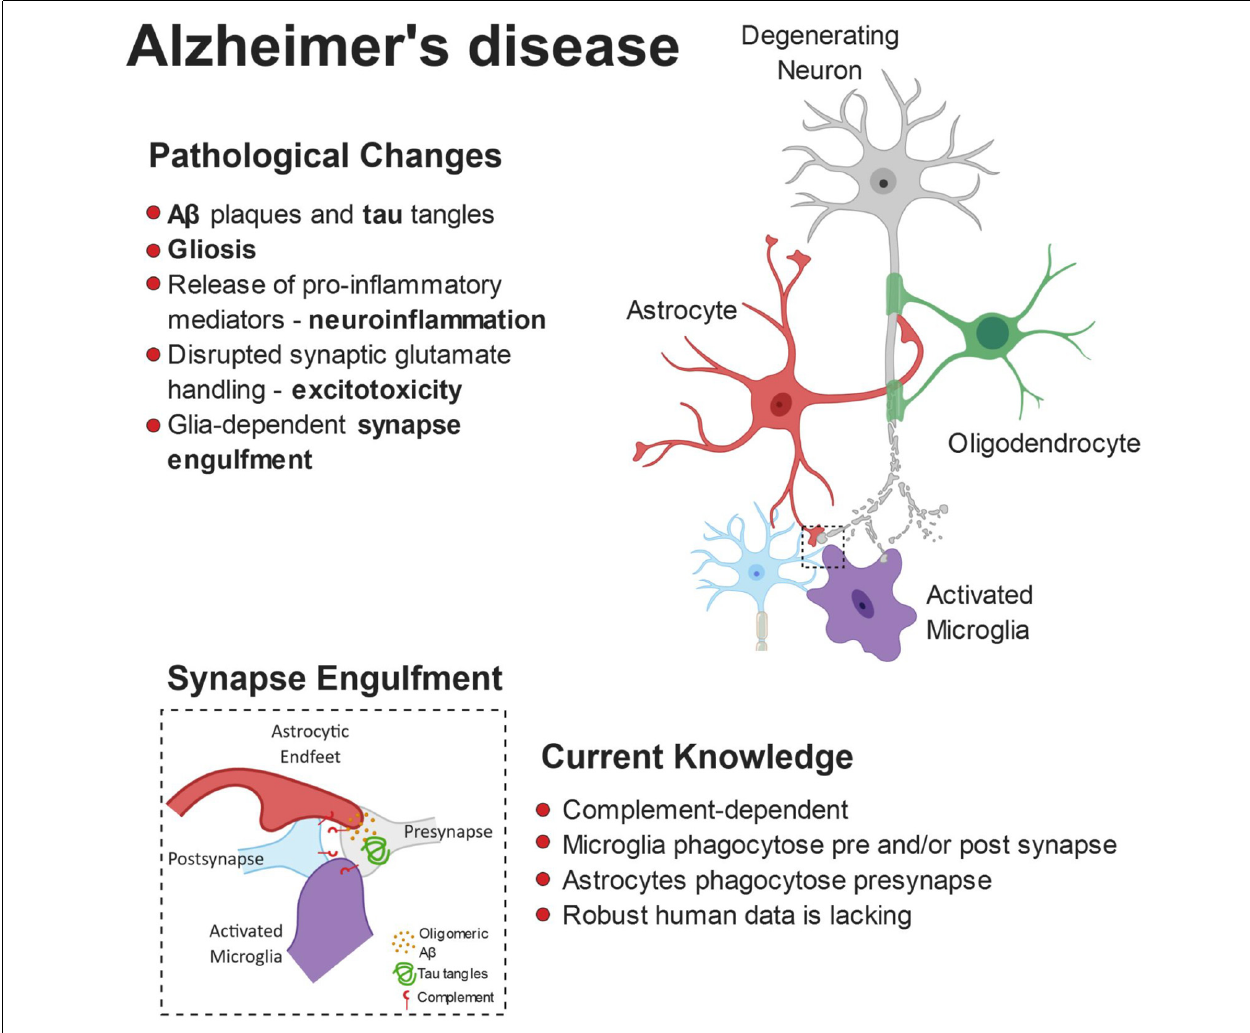
FIGURE 2 | Pathophysiology of Alzheimer’s disease (AD). The build-up of pathological amyloid and tau species leads to neurodegeneration via numerous autonomous and non-autonomous pathways. Glial cells release pro-inflammatory mediators and lose their ability to regulate glutamate homeostasis, leading to synaptic dysfunction. Furthermore, the synaptic accumulation of proteins from the complement system leads to glial-dependent synapse engulfment and